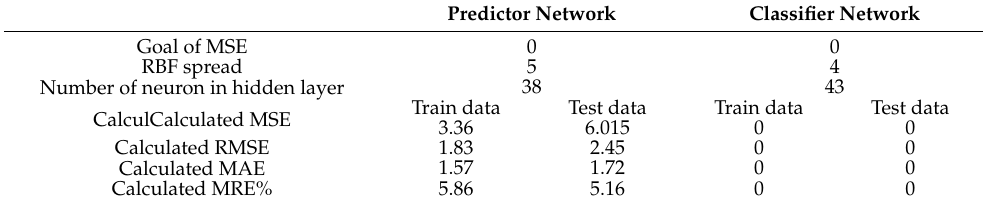
Table 1. Specifications of the designed